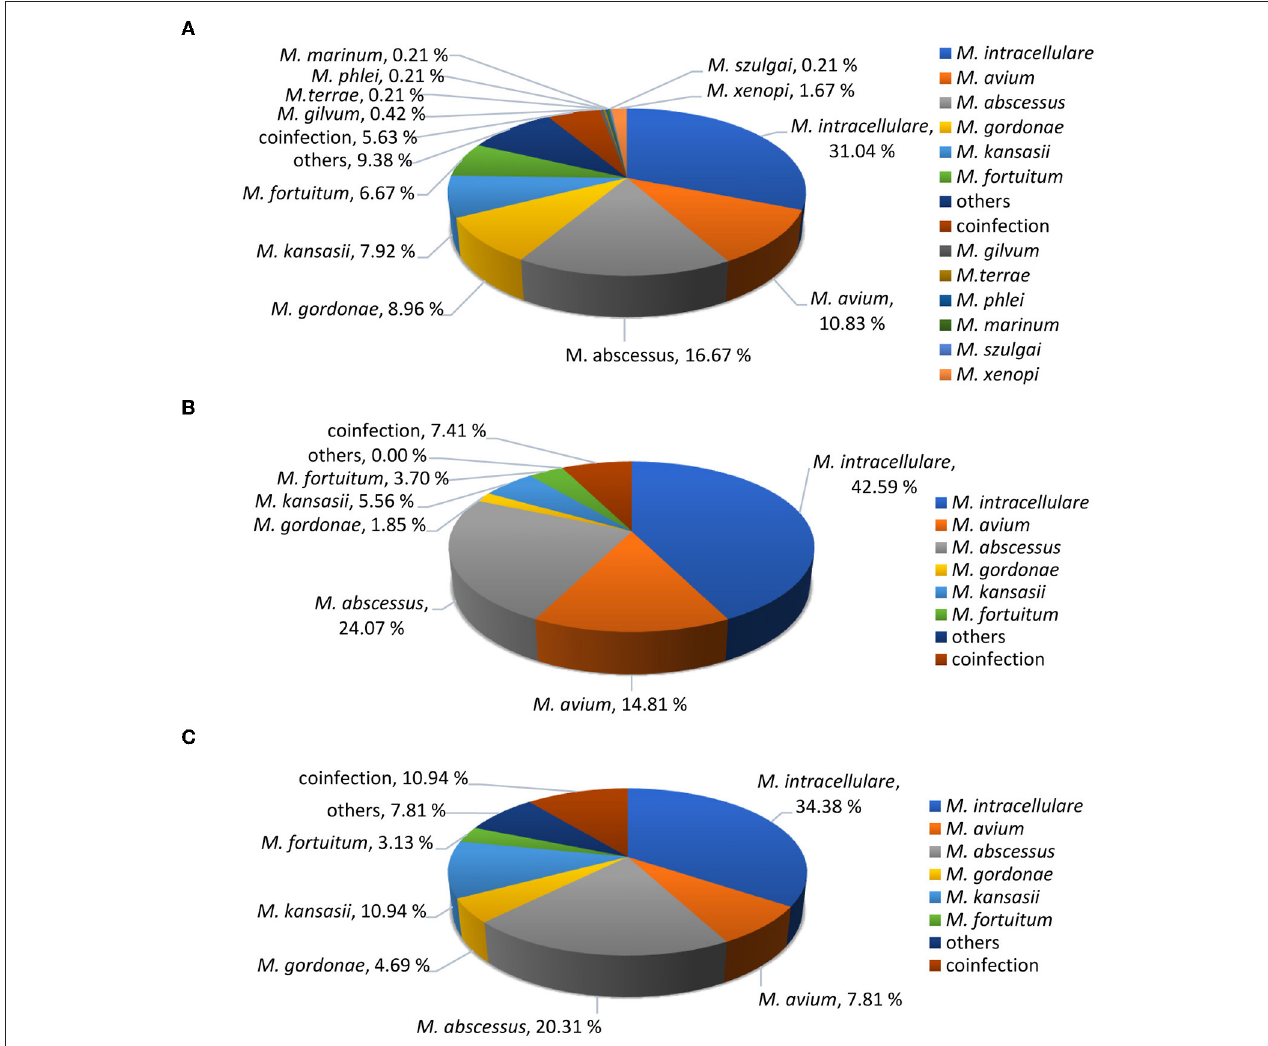
FIGURE 2 | Identified NTM species percentages. (A) Total suspected NTM patients ( n = 480). (B) Diagnosed NTM infections in immunocompetent patients ( n = 54). (C) Diagnosed NTM infections in immunocompromised patients ( n = 64).